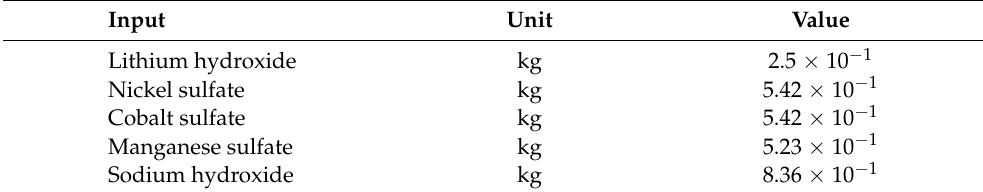
Table 6. Material input needed for one kilogram of NMC cathode